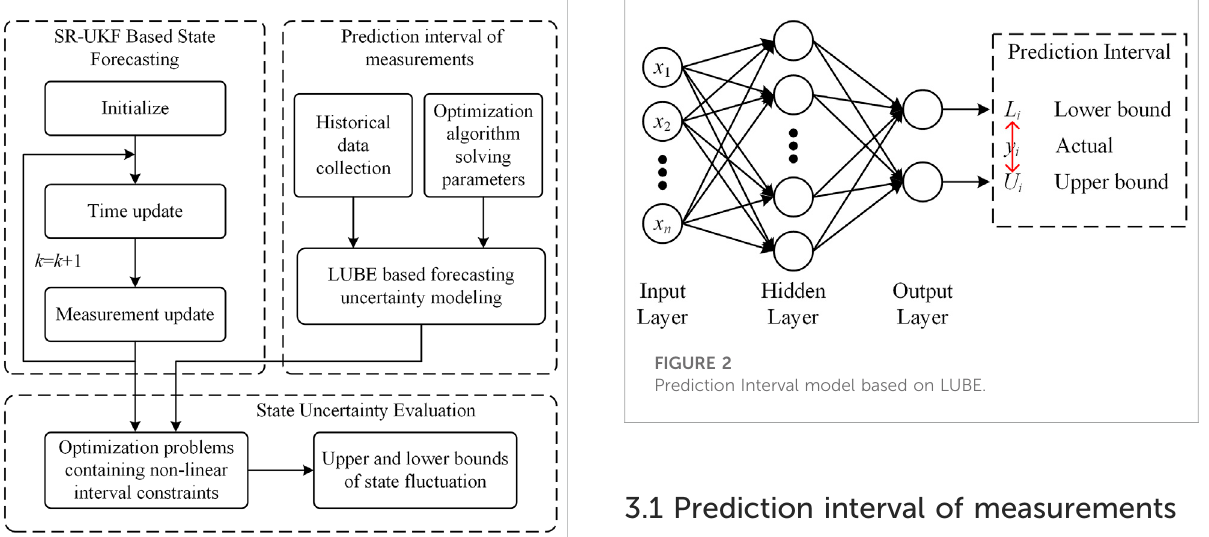
FIGURE 1 The overall structure of Interval dynamic state estimator.